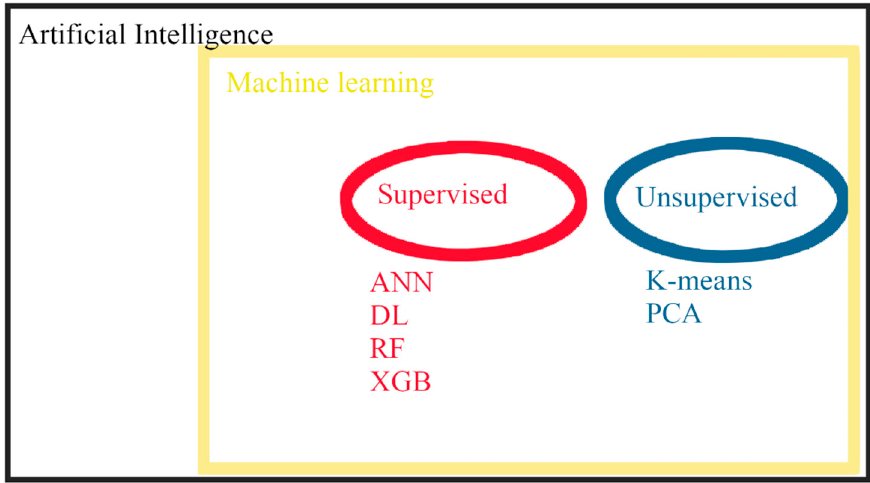
Figure 1. Artificial intelligence, machine learning, and their classification. ANN—Artificial Neural Networks, DL—Deep Learning, RF—Random Forest, XGB—XGBoost, K-means—K-means Cluster- ing, PCA—Principal Component